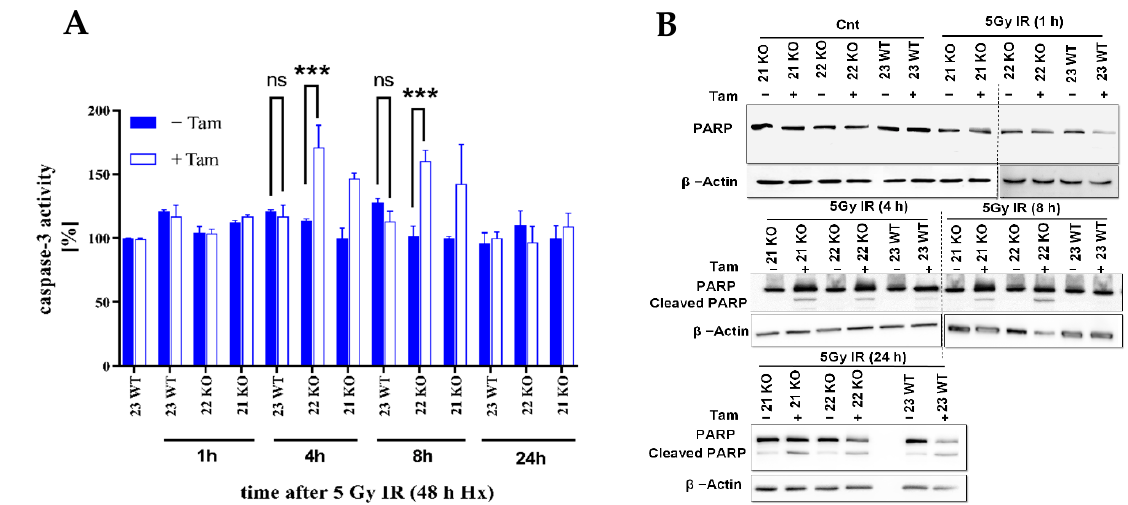
Figure 8. Analysis of apoptosis induction in hypoxic HIF-1 α deficient mHDC. ( A ) The activity of caspase-3 was measured in mHDC lysates. Cells were irradiated and incubated in hypoxia for the time indicated. The cells were then lysed, and 10 μ g protein were incubated with Ac-DEVD-amido-4-methylcoumarine. Generation of the fluorescent product was monitored at 430 nm. Caspase-3 activity data showed representative experiments with n = 6, each experiment was repeated three times. Graphs show mean ± SD, groups were compared using two-way ANOVA, *** p < 0.001, ns p > 0.05. ( B ) Western blot with a PARP-1 antibody which detects full-length PARP and a cleaved species with a lower molecular weight indicative of PARP cleavage, a signature of apoptosis. The cells were incubated in hypoxia for 48 h, then irradiated with 5 Gy, and transferred back to hypoxia for the time indicated. The cells were then lysed and subjected to SDS-PAGE and Western blotting. The data show a representative Western blot from three independent experiments.